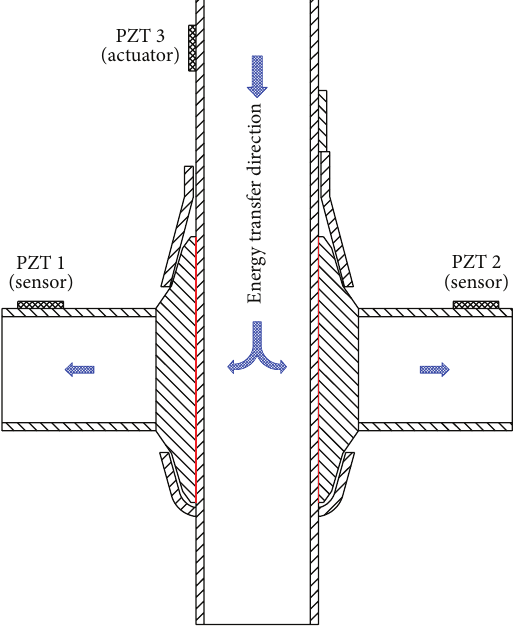
Figure 3: Energy transmission at the cuplock scaffold